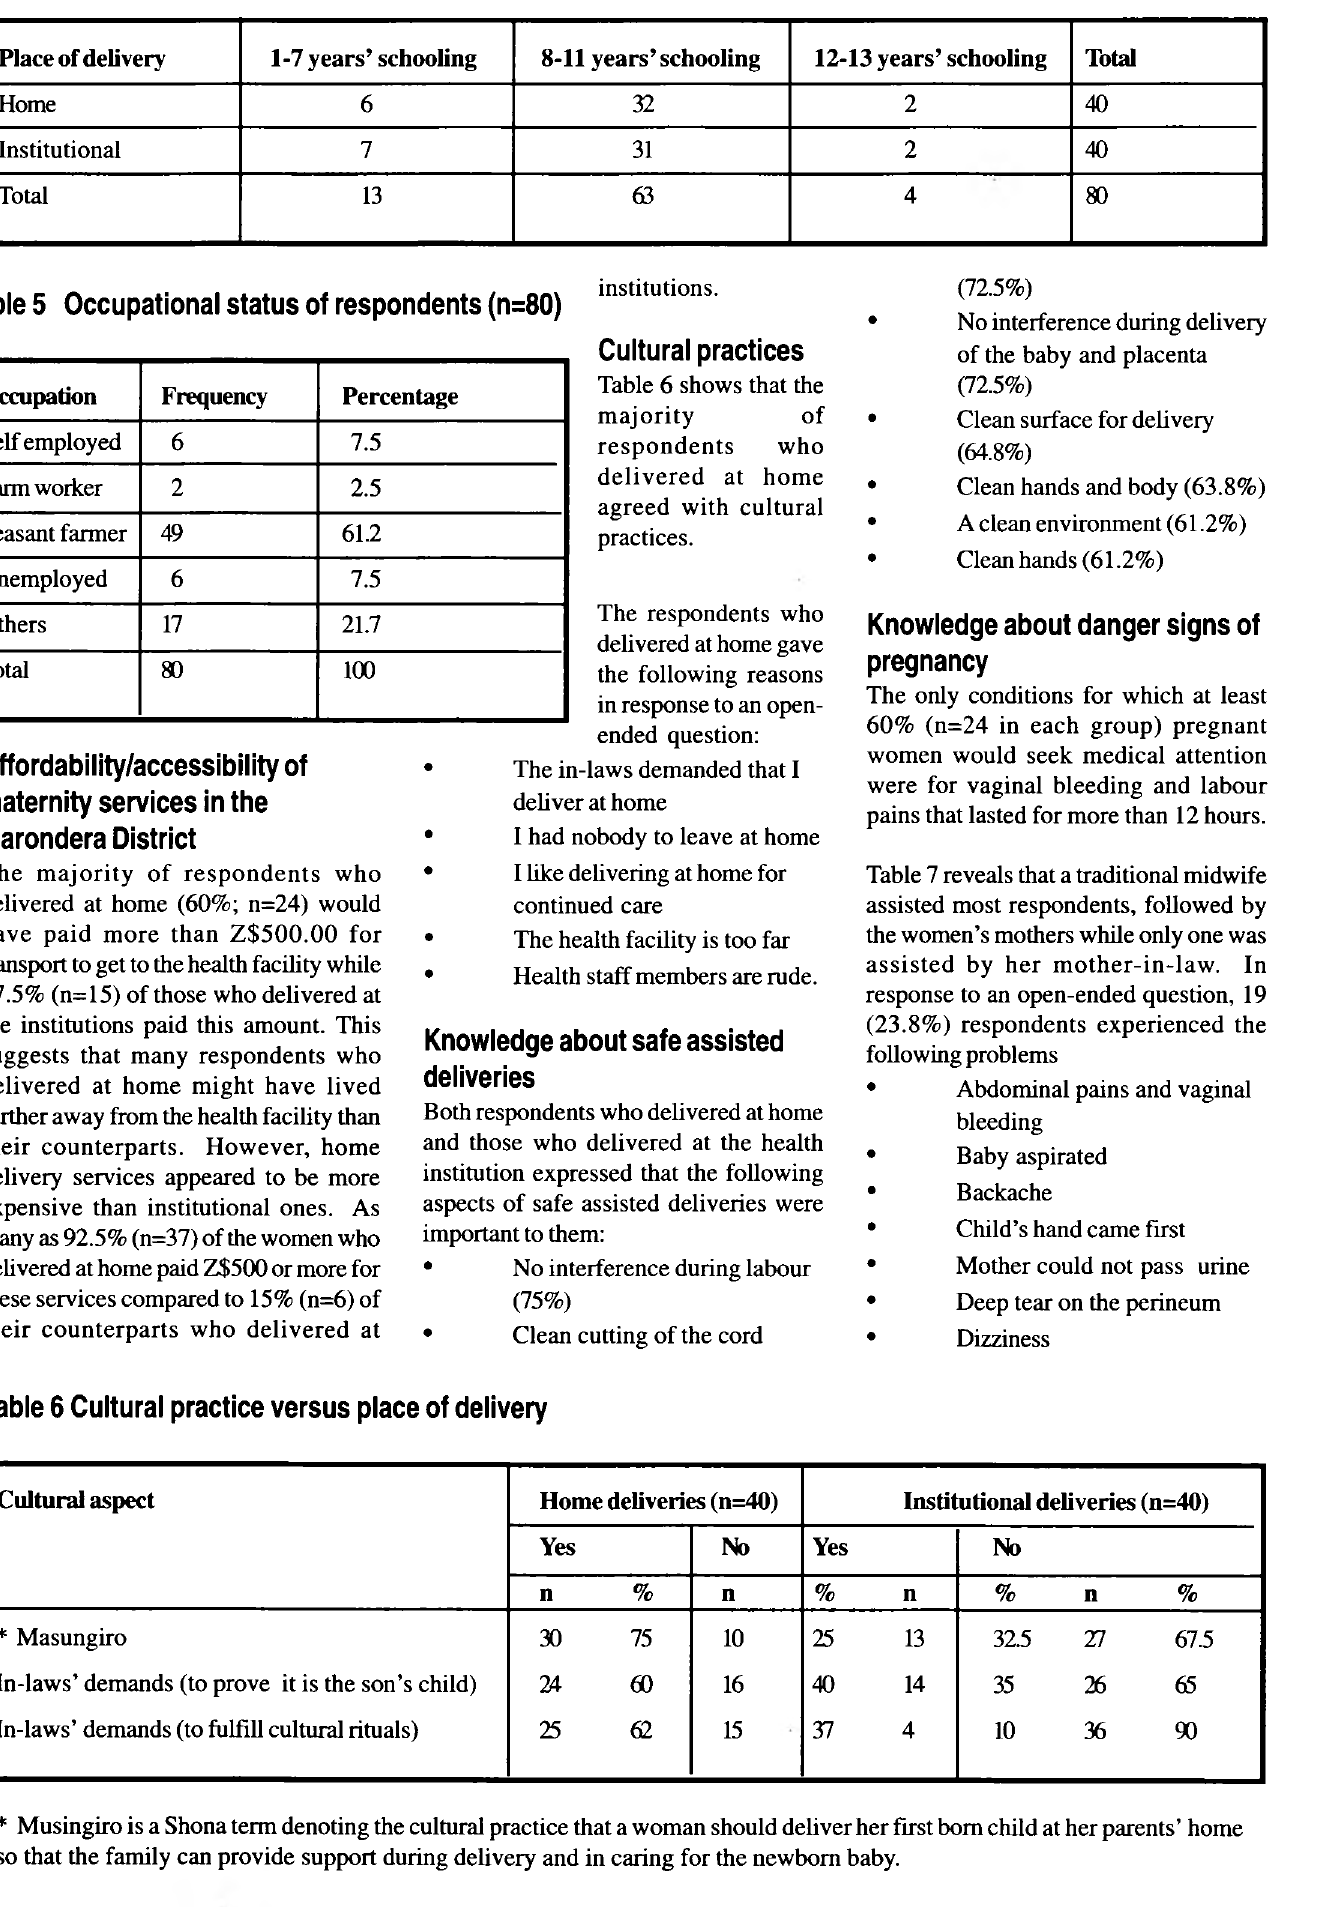
Table 4 Level of education: institutional versus home deliveries (n=80) Place of delivery